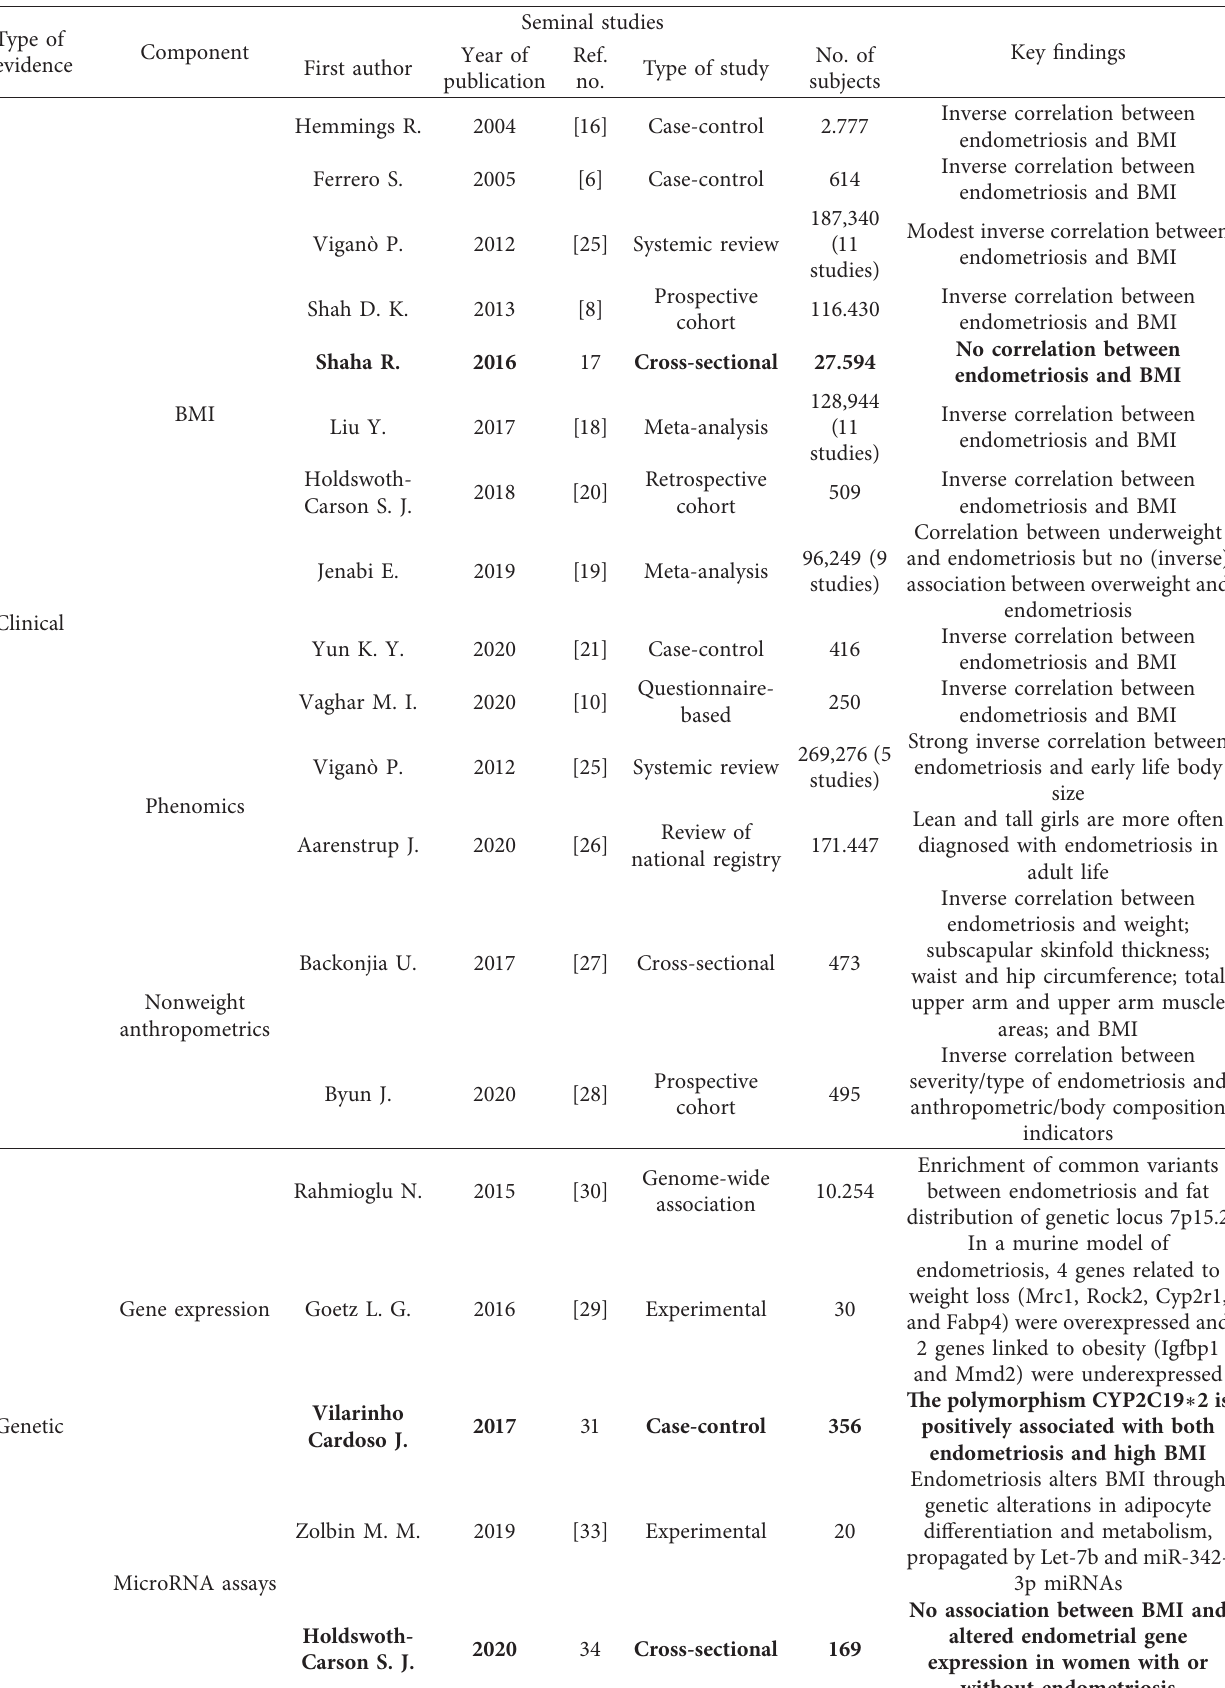
Table 2: Summary of the included studies on the correlation between endometriosis and obesity. The studies that found no or positive correlation are in